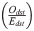
Standardized incidence ratio OdstEdstfor TB.